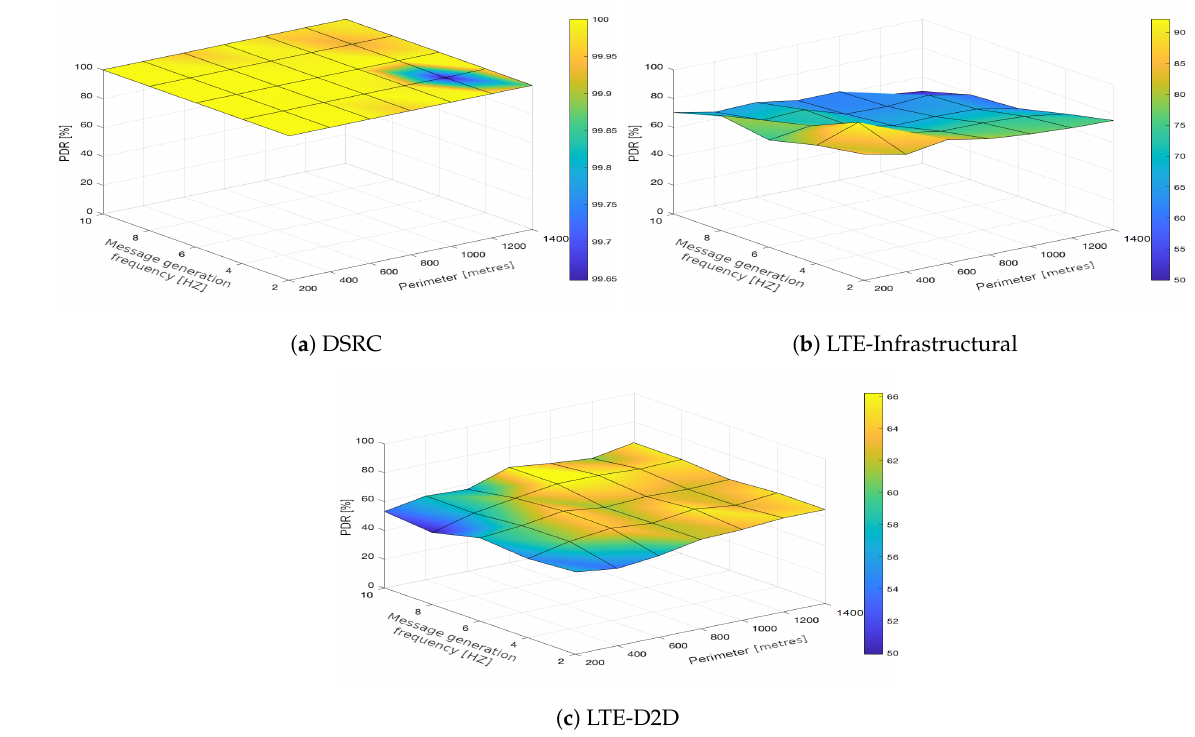
Figure 6. Packet delivery ratio obtained for the traffic intensity of 1250 vehicles per hour.